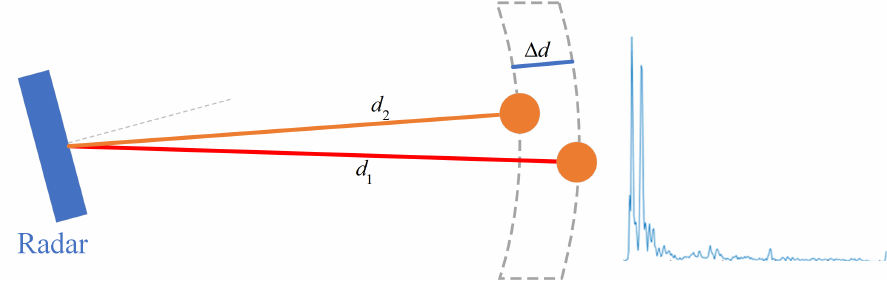
Figure 1. Distance information contained in a Chirp